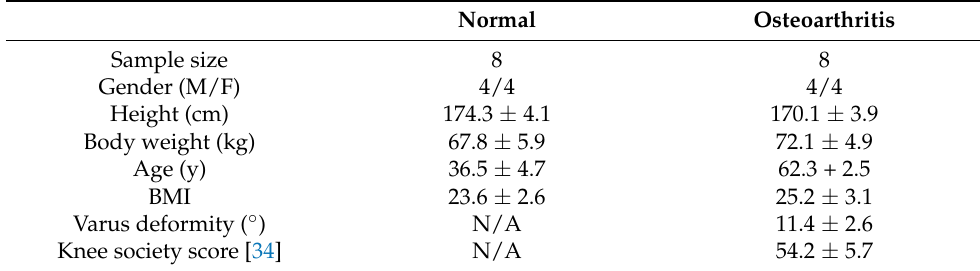
Table 2. Demographic information of patients.